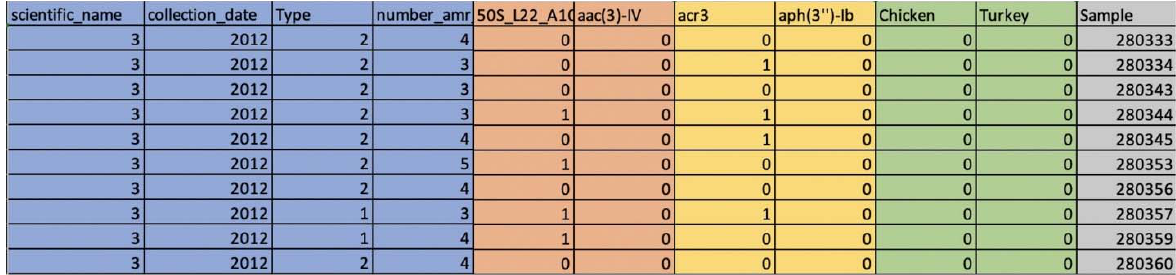
Figure A1. Example data table from the US data. The shaded blue columns correspond to the scientific names of pathogens, the date of sample collection, the type of pathogen source (clinical represented with a “1” and environmental represented with a “2”), number of AMR genes the sample is resistant to. Additionally, the shaded orange columns indicate whether a specific stress response gene was (“1”) or was not (“0”) detected in the sample. The following yellow columns indicate whether the sample resisted an antimicrobial gene (“1”) or not (“0”). Overall, the number of columns varied depending on the country. KEY: Blue = sample properties (pathogen name, collection year, source (clinical = 1, environmental = 2), # of AMR genes). Orange = whether the stress response gene was detected (1 = was, 0 = was not). Yellow = whether the AMR gene was detected (1 = was, 0 = was not). Green = source of sample. Grey = sample number.